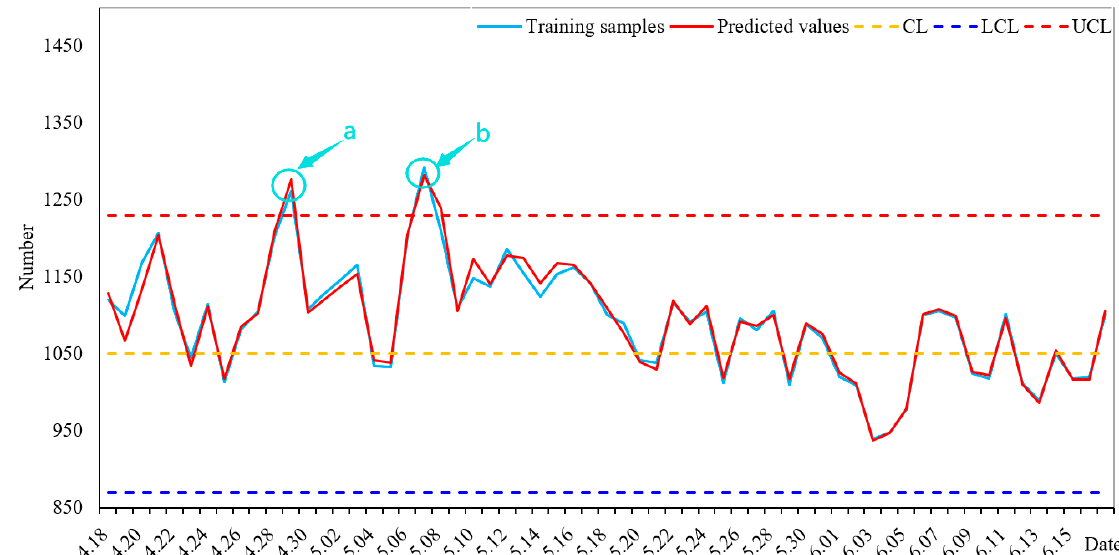
Figure 11. Control chart analysis (Point a and point b are data exceeding the upper limit of con-